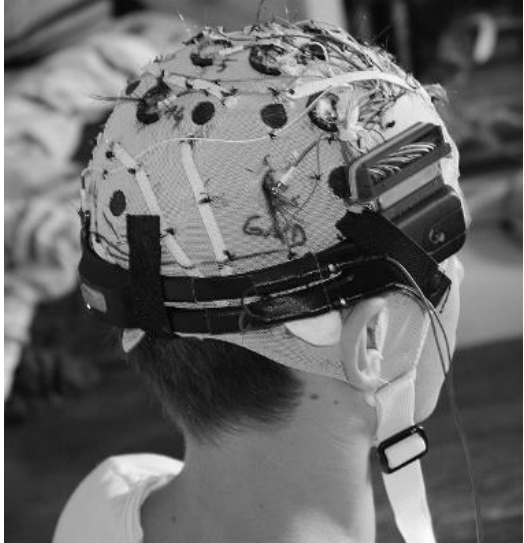
Figure 4. The modified Emotiv system combined with a standard electrode cap. A connector was fixed above the part of the headset containing the amplifier circuits. The two cables connected the headset with the photodiode used for the synchronisation of stimulation and EEG recording at the start and end of each experimental run. During rowing, the cables were removed.